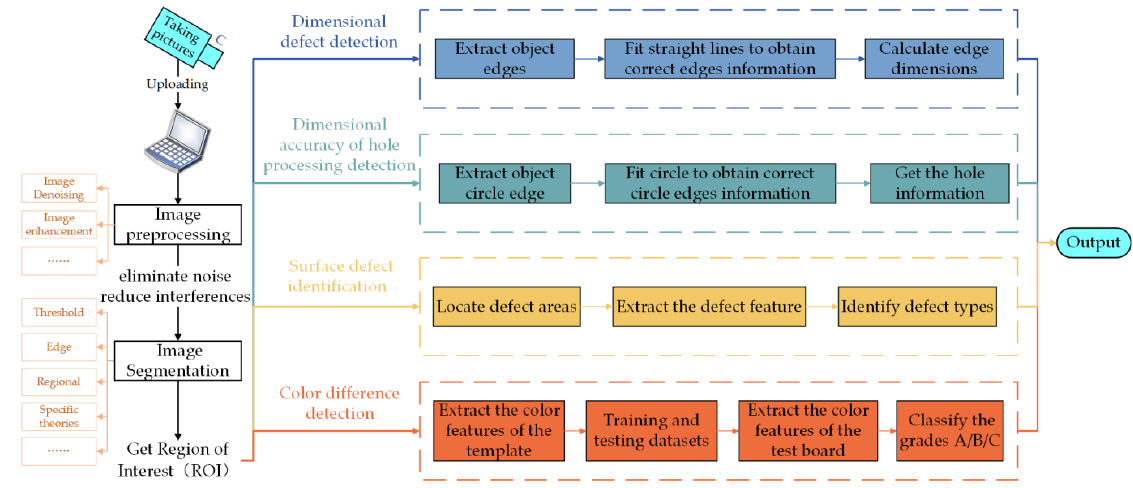
Figure 5. Technical roadmap of quality detecting technology based on MV.